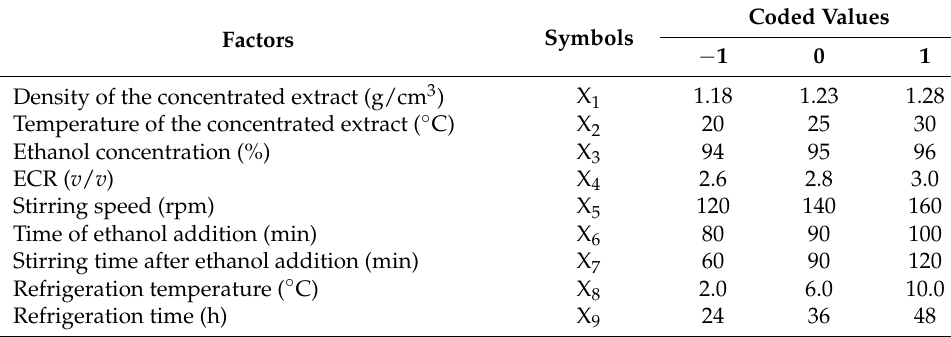
Figure 1. The schematic diagram of the experimental setup. Table 1. The level of experimental